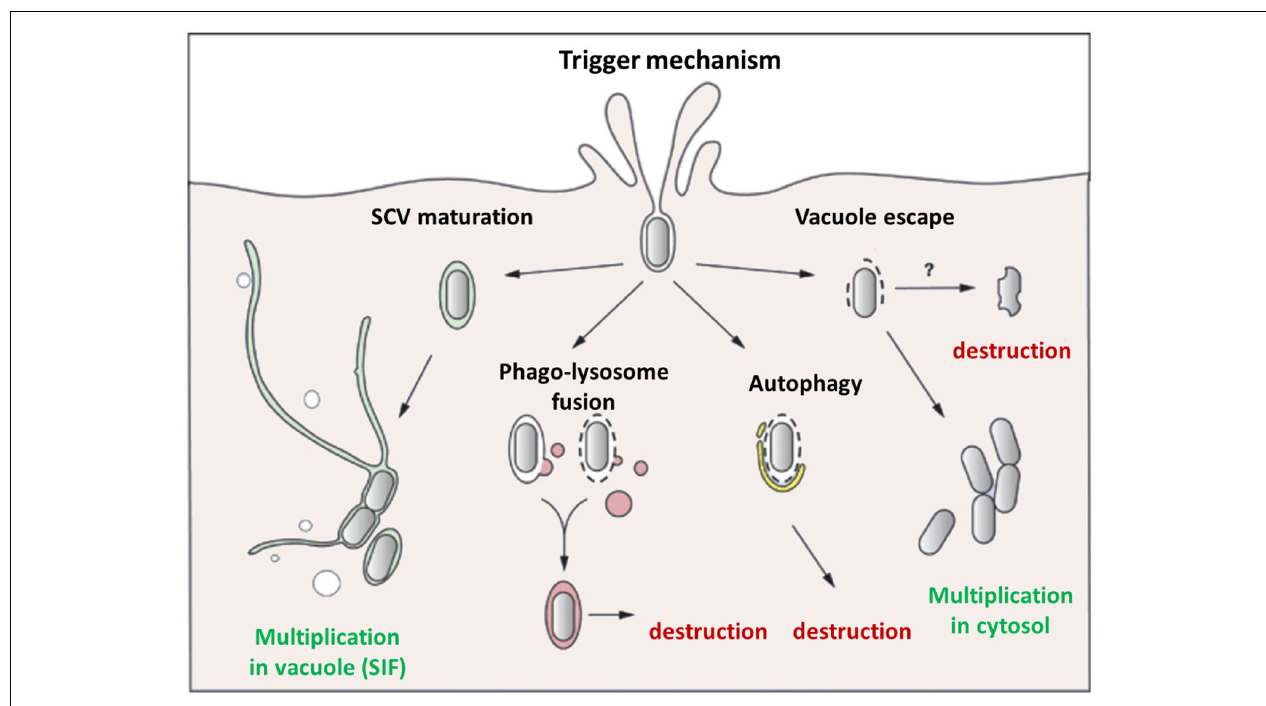
phago-lysosome triggering intra-vacuole destruction or autophagy. In other cases, Salmonella damages the SCV membrane triggering vacuole destruction, allowing bacteria to escape into the cytosol, where they can be destroyed, particularly in activated macrophages, or multiply extensively especially in epithelial cells. No data have been obtained for the Zipper mechanism induced by